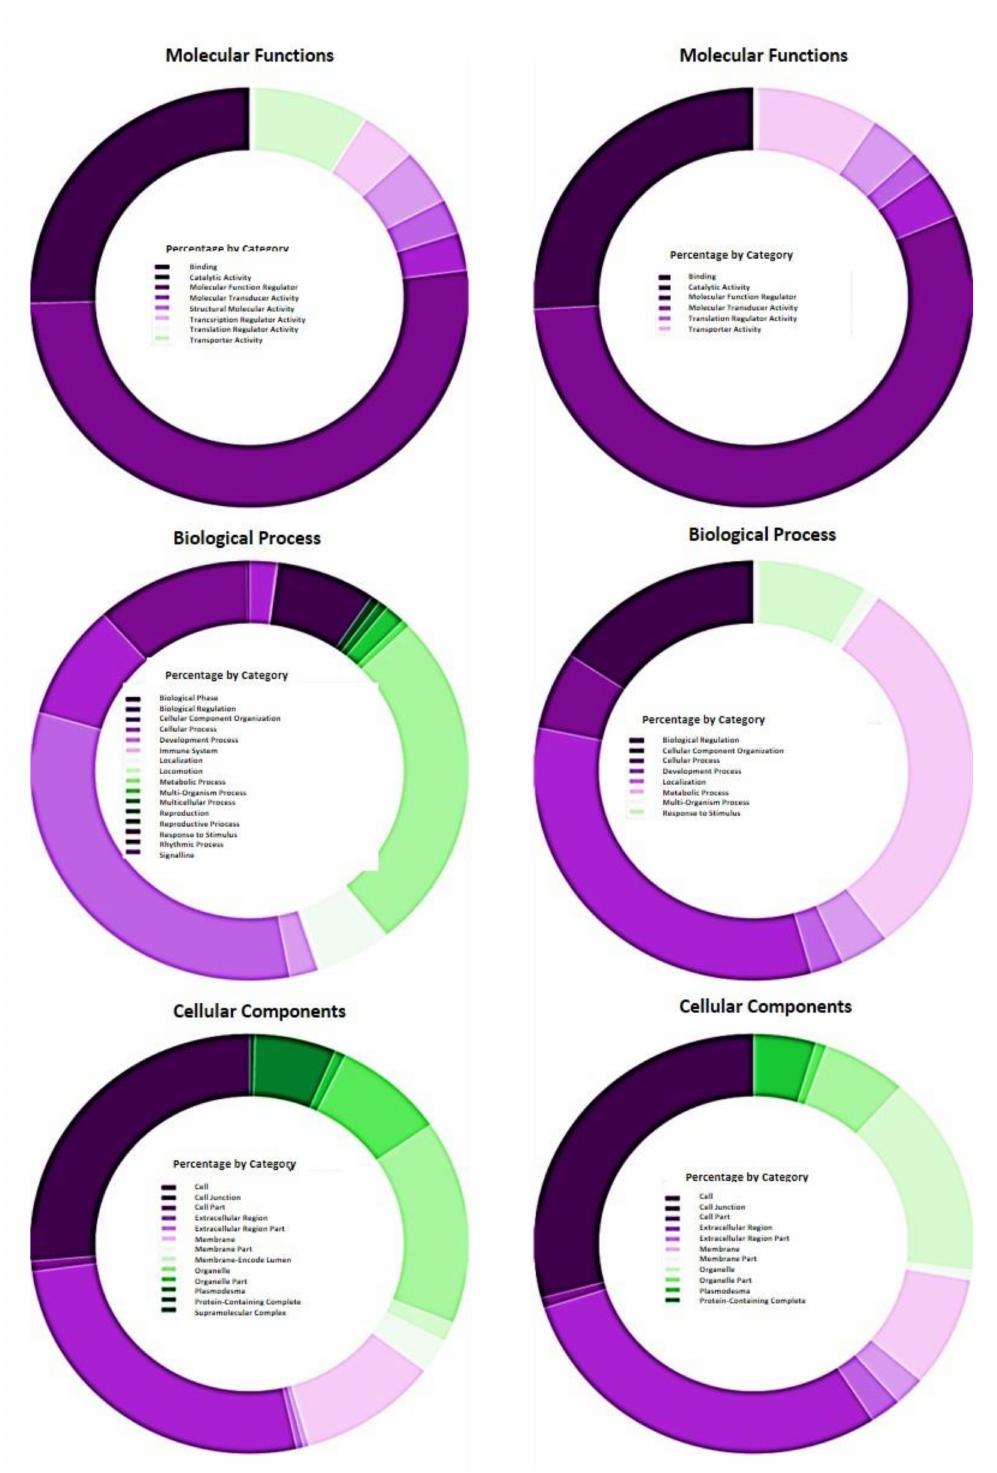
Figure 2. GO term categories obtained by PANTHER. Functional analysis of differentially expressed genes including all comparisons (3210; left side) and functional analysis of filtered differentially expressed genes (147; right side). Diagrams show percentage of GO term categories showing the total of each domain for “Cellular Components”, “Biological Processes” and “Molecular Functions”